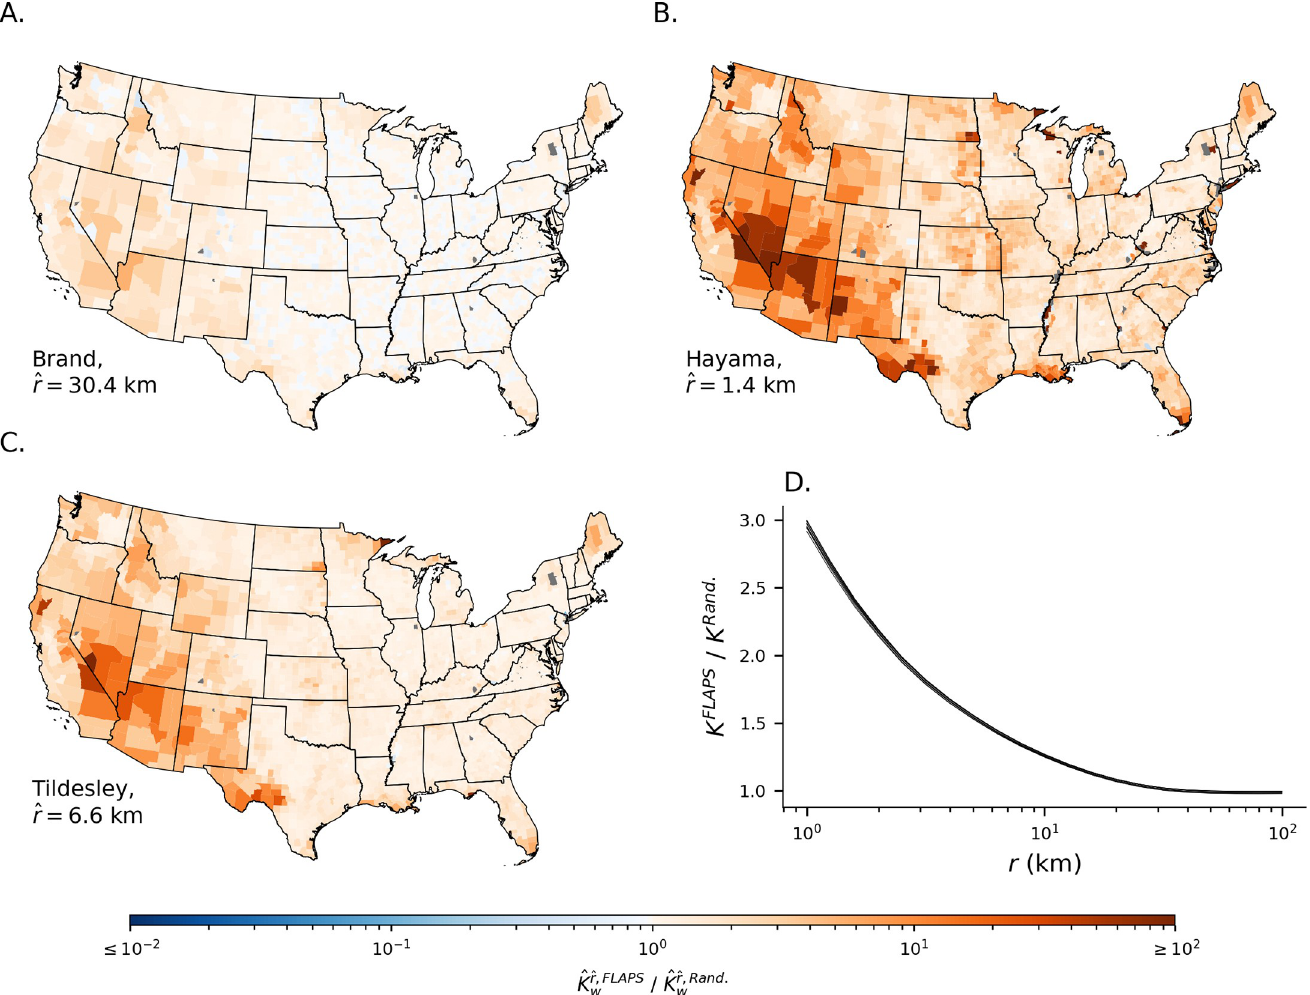
Fig 2. Landscape-level clustering. (A-C) Relative change in county level clustering, ^ K , when going from randomized configuration to FLAPS for spatial scale ^ r w where the respective kernel functions had fallen by 95% of H(0) . (D) Landscape-level relative change in clustering measured as Ripley’s K at different radii when going from randomized configuration to FLAPS. The panel shows ten nearly indistinguishable lines, each indicating the difference between one FLAPS realizations and its randomized counterpart.